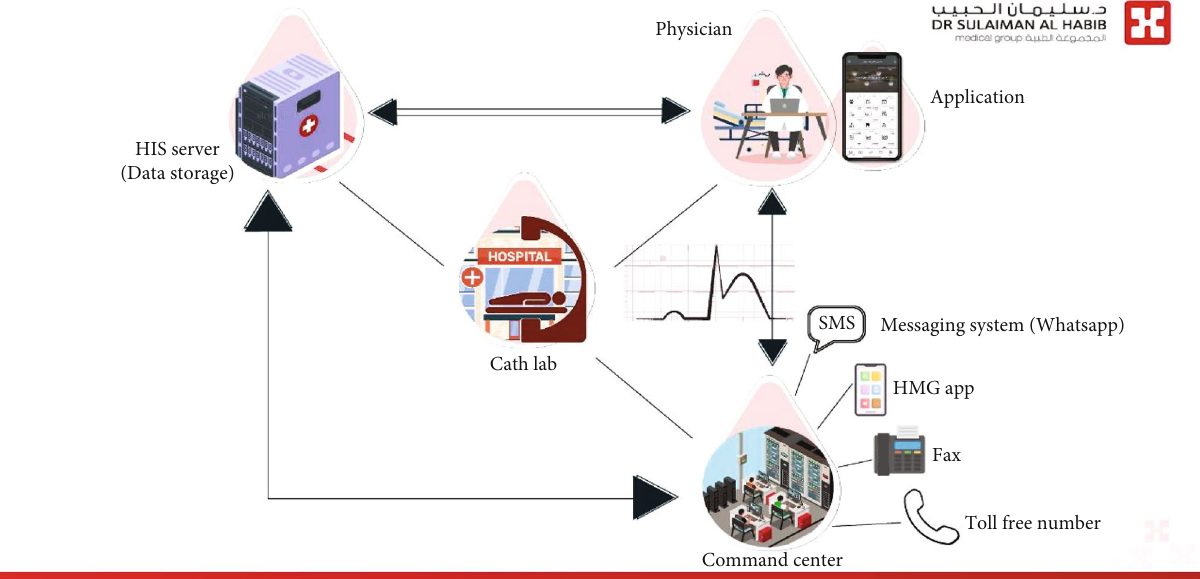
Figure 4: STEMI telecardiology